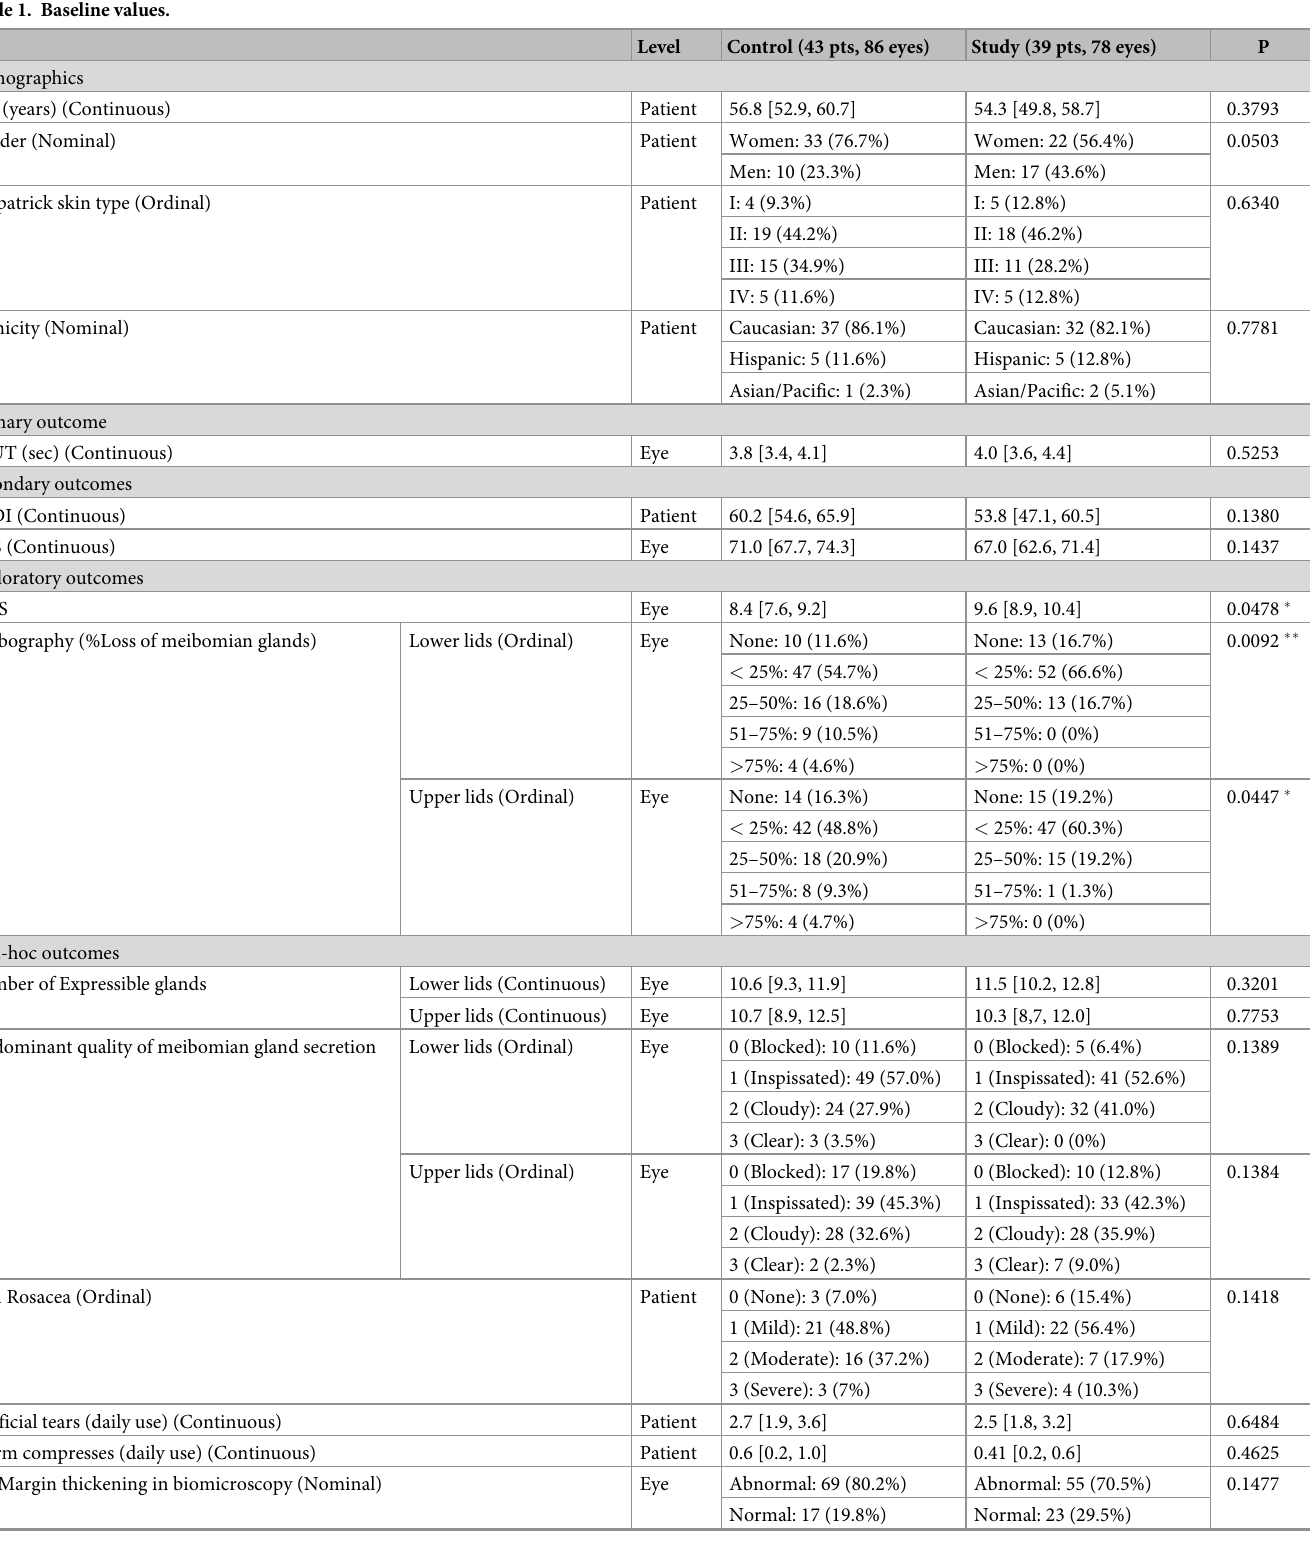
Table 1. Baseline